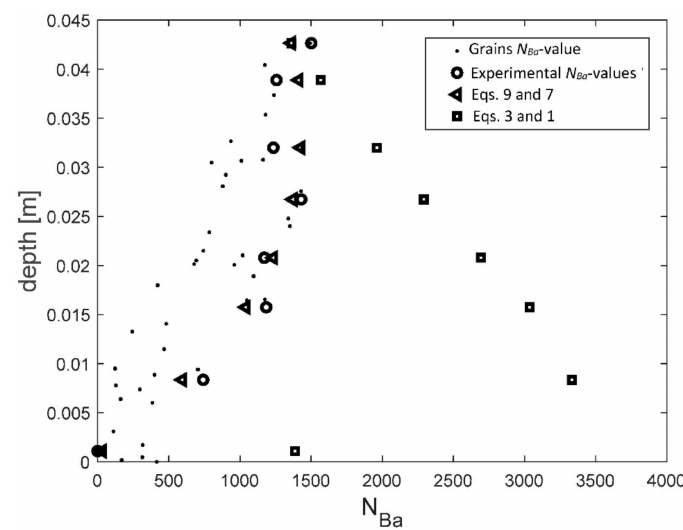
Figure 8. Comparison between the N Ba -values by using the experimental velocity profile (experimental N Ba -values), the N Ba -values estimated by applying Equations (9) and (7) and the N Ba -values estimated by applying Equations (3) and (1). The dots represent the N Ba -values of selected grains; (the x -axis indicates the N Ba -values; the y -axis indicates the distance from the upper level of the static bed).